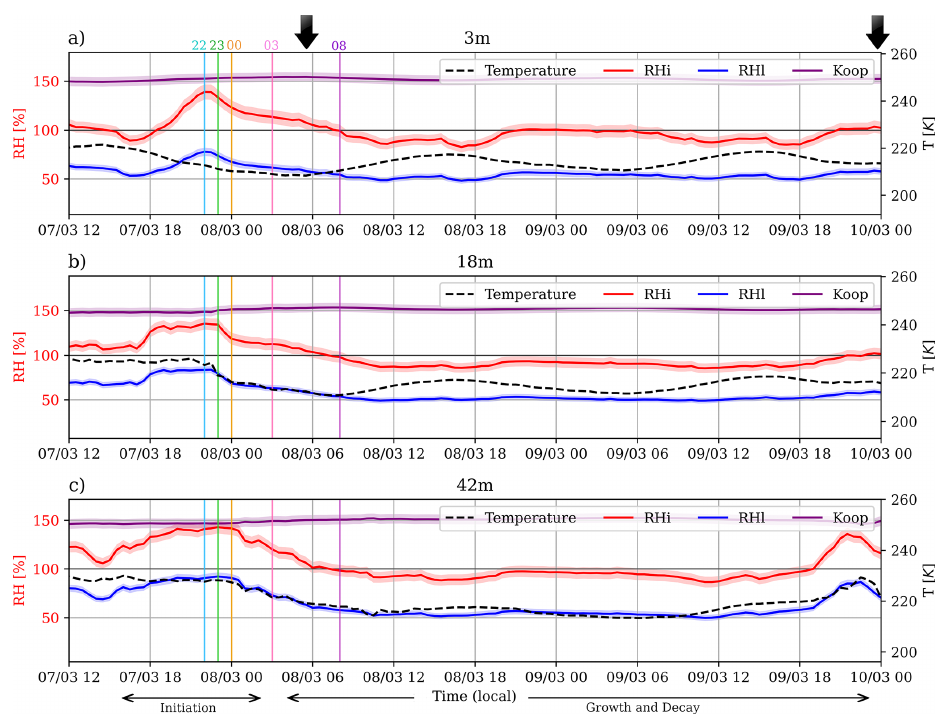
Figure 4. Time series of the temperature (dashed black line) and relative humidity with respect to ice (RHi, solid red line) and liquid water (RHl, solid blue line) at 3 (a) , 18 (b) and 42ma.g.l. (c) . The red and blue shading shows the RH uncertainty ranges as estimated in Appendix A. The purple line shows the homogeneous freezing RHi threshold value of Koop et al. (2000). The 100% RH value is highlighted with a solid black line. Vertical coloured bars indicate the times at which vertical profiles are analysed in Fig. 5. Black arrows indicate the times at which the fog visually appears and disappears near the surface in the lidar